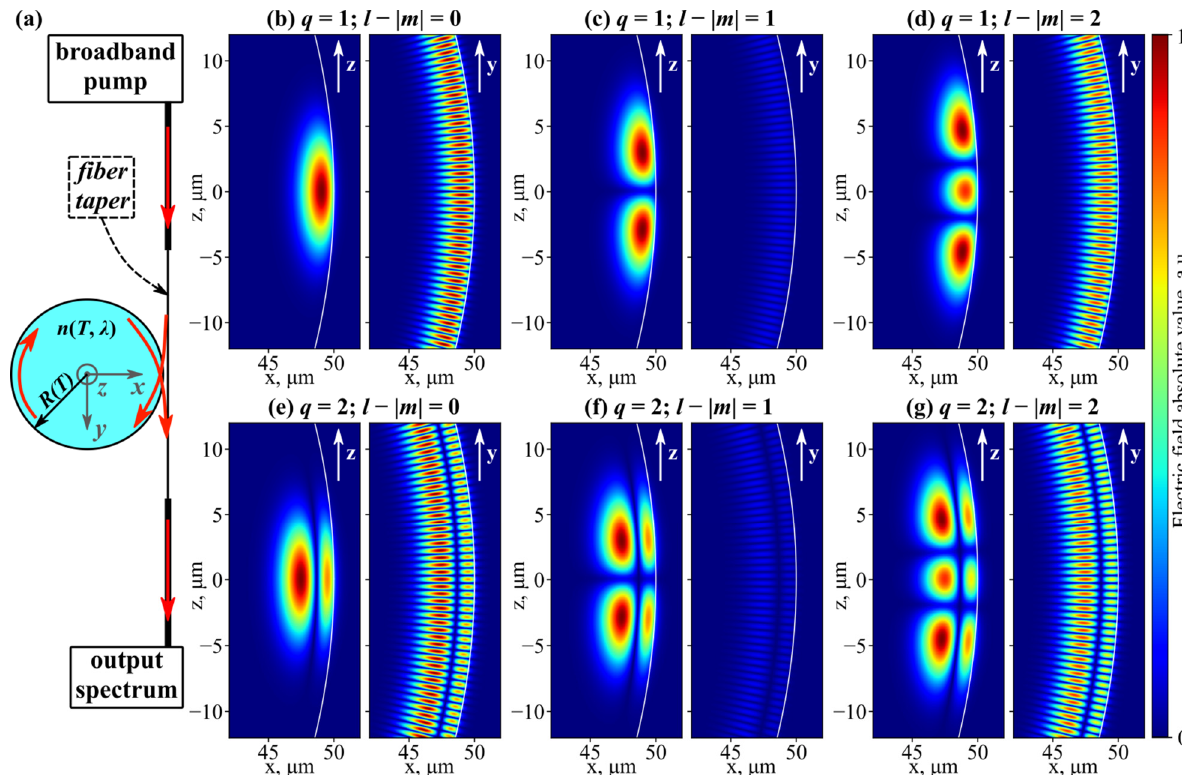
Figure 1. ( a ) Schematic of temperature microsensor; red arrows show light propagation direction. ( b – g ) Spatial distribution of electric field absolute value for WGMs with different indices (exact expressions are rather cumbersome and can be found in [38]). Eigenmodes shown in the same row have equal frequencies; color scale is identical for all figures. All calculations are for SiO 2 microsphere with radius 50 μ m.